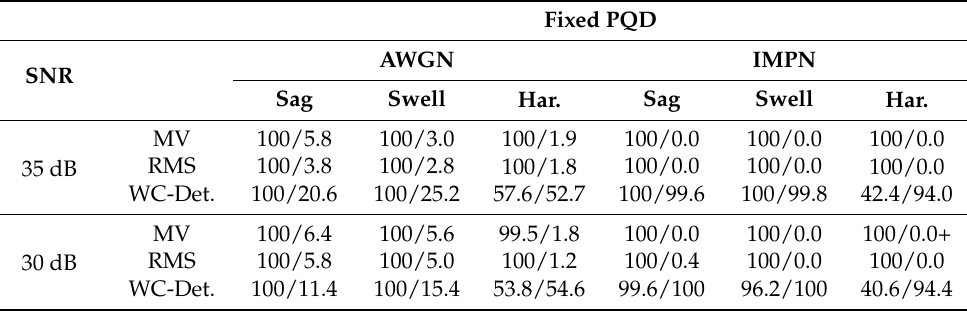
Table 8. Double-edge-based detection performance (DR/FER (%)) of the proposed algorithm, for which a sag signal with 78% pu , a swell signal with 111% pu generated from the implemented network model of Figure 7a, and a harmonics signal with 10% pu generated from the implemented network model of Figure 7b are generated over AWGN channels with SNR = 30–35 dB or IMPN channels with SNR = 30–35 dB, µ = 400, and ψ =